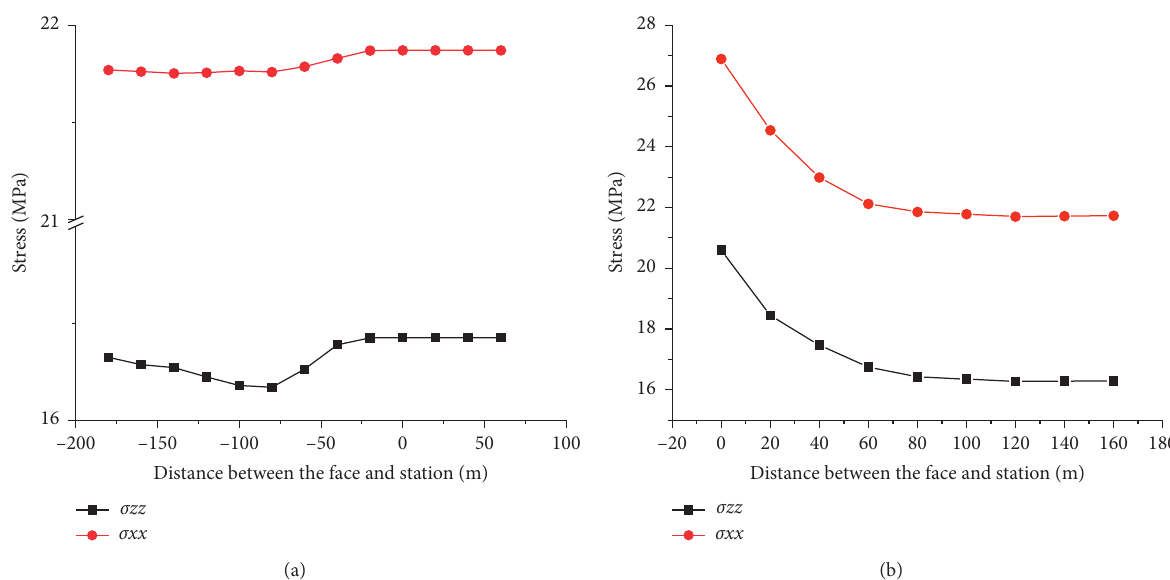
Figure 16: Local model stress conditions from the global model: (a) roadway excavation; (b) longwall retreatment.